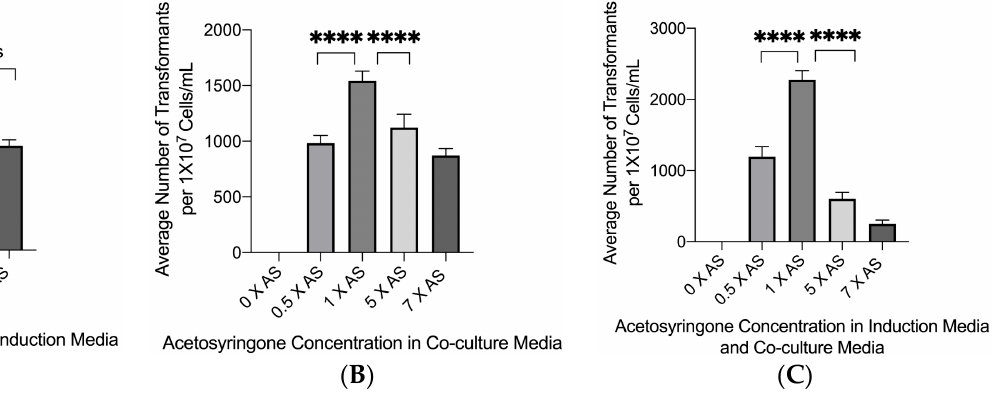
Figure 3. The influence of acetosyringone concentration on transformation frequency. ( A ). Agrobacterium tumefaciens strain with plasmid p624 was cultured in induction media with various concentrations of acetosyringone and shaken for 6 h at 28 °C at 250 RPM and then mixed with wild-type C. glabrata , which were then placed onto nitrocellulose membranes and plated onto co-culture medium with an acetosyringone concentration of 1 × AS for 72 h at 26 °C. Brackets with **** above bars indicate groups with statistically significant differences. No significant difference indicated with ns. **** = p ≤ 0.0001, ns = p > 0.05. ( B ). Wild-type C. glabrata and A. tumefaciens were incubated on co-culture medium with various concentrations of acetosyringone for 72 h at 26 °C (the acetosyringone concentration in induction media was 1 × AS). Brackets with **** above bars indicate groups with statistically significant differences. **** = p ≤ 0.0001 ( C ) Combined acetosyringone conditions from ( A , B ). Brackets with **** above bars indicate groups with statistically significant differences. **** = p ≤ 0.0001.